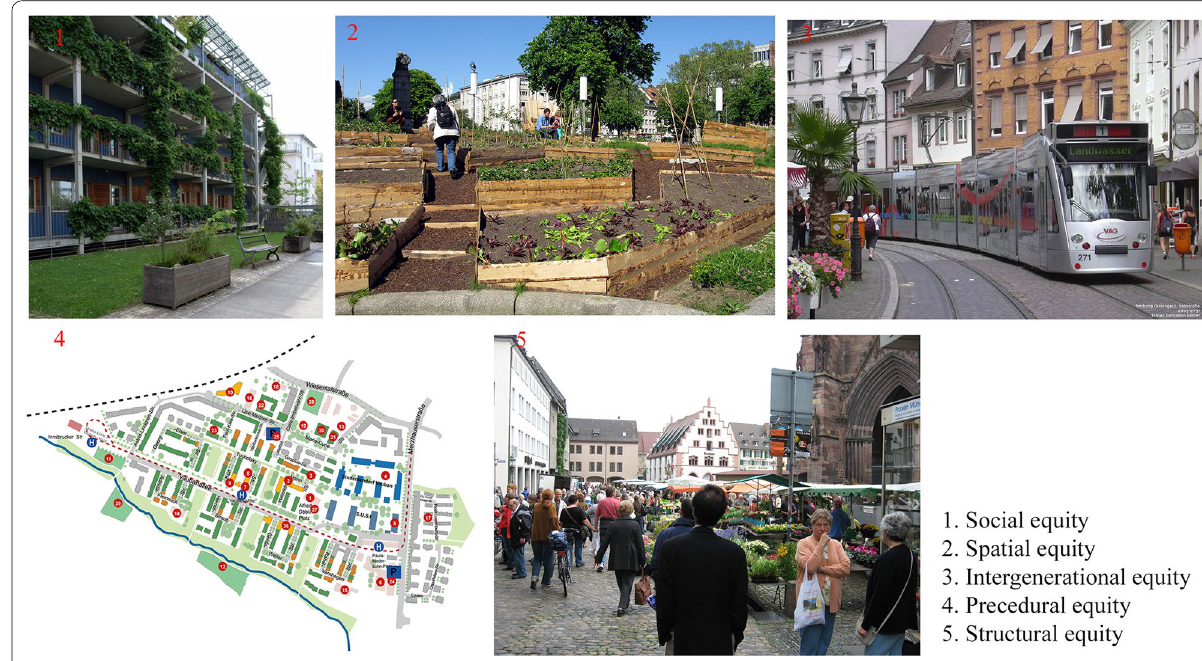
Fig. 2 The principle of equity postulated in the concept of sustainable development in the interventions realized in Freiburg GE (Source: 1. http:// www.ecoqu artie rs-genev e.ch/index .php?page vauba n-2. https ://commo ns.wikim edia.org/wiki/File:Urban _Garde ning_vor_dem_Theat er_Freib = urg.jpg–3. http://famil ypedi a.wikia .com/wiki/Freib urg_im_Breis gau4. https ://freib urg-vauba n.de/en/quart ier-vauba n-2/–5. http://flati ronbi ke.com/2013/04/04/susta inabl e-trans porta tion-in-freib